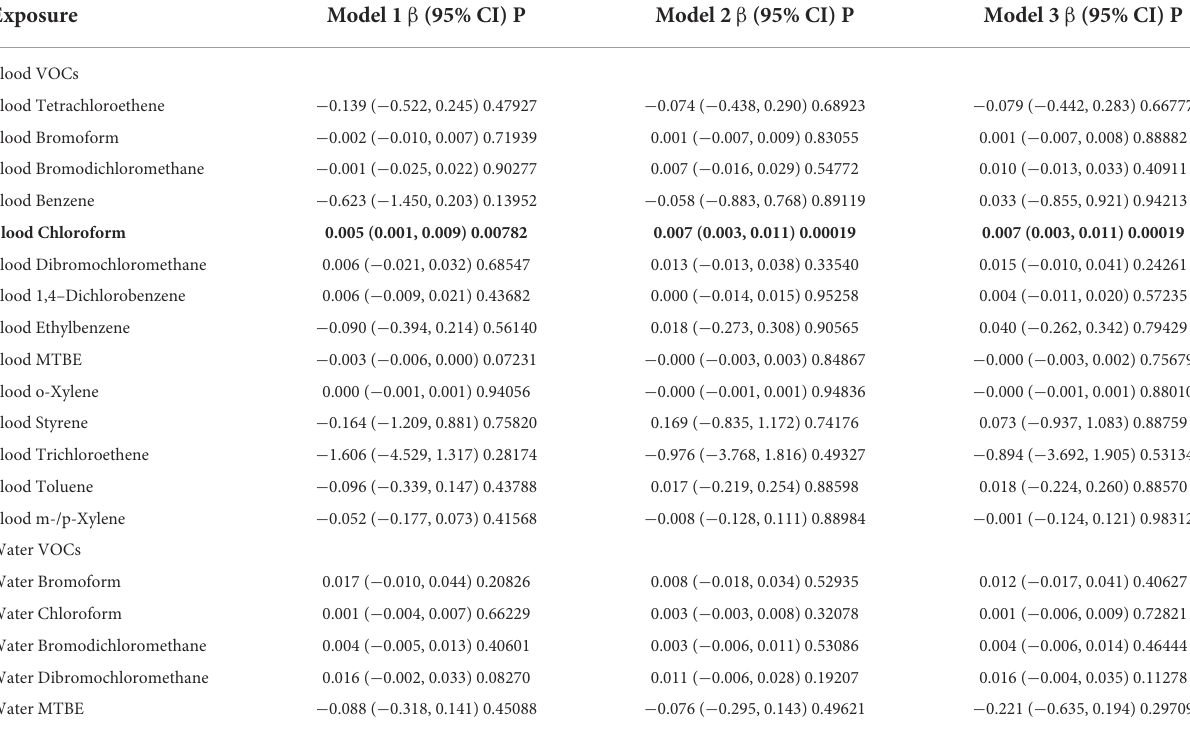
TABLE 2 Multivariate weighted linear model analysis reveals the association between the blood VOCs and PSA concentration.